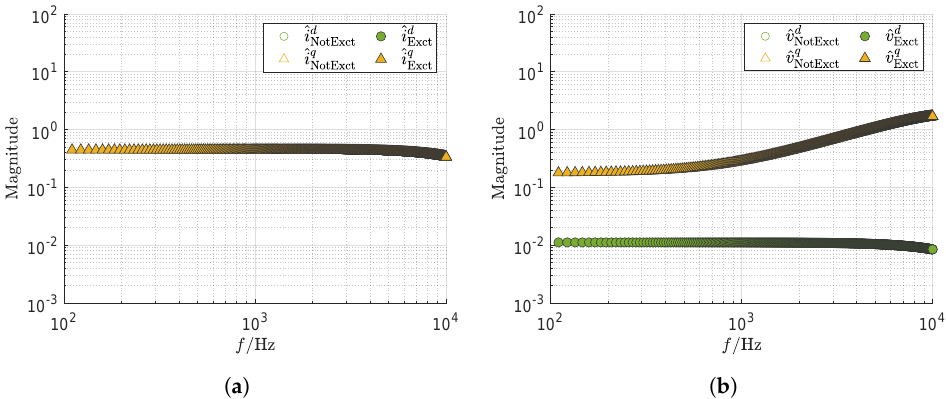
Figure 13. Measurement of the ideal impedance scenario during excitation of the q -axis. ( a ) Spectrum of the current i meas in the dq domain. ( b ) Spectrum of the voltage v meas in the dq domain. The relationship between the spectrum of the measured excitation current ˆ i meas and the spectrum of the voltage response ˆ v exct is given by (15), which shows that the voltage drop of the harmonics current at grid impedance is measured.